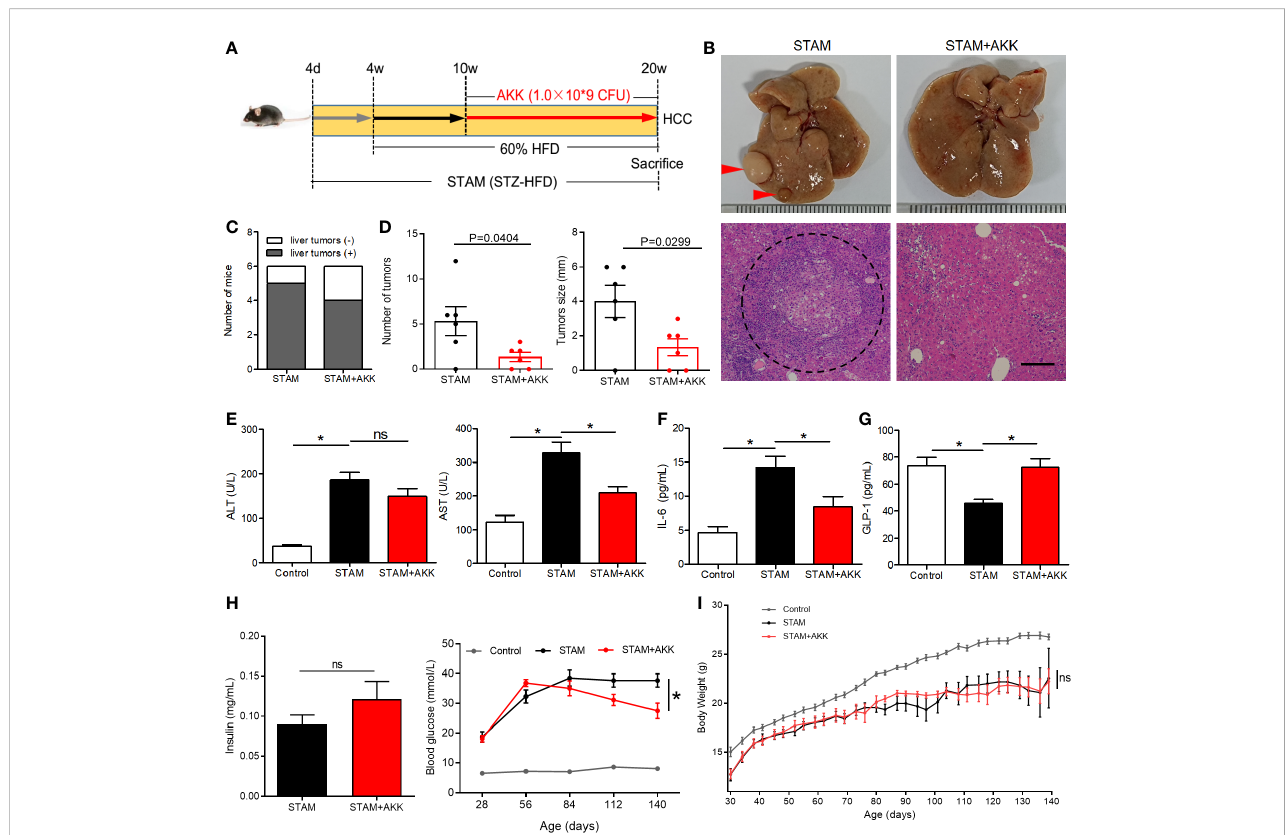
FIGURE 4 A muciniphila administration blunted hepatocarcinogenesis in STAM mice. (A) Experimental design and protocol. STAM mice were treated with A muciniphila or saline (Control) starting at 10 weeks of age for 10 weeks, and were killed at 20 weeks of age (n=6/group). (B) Macroscopic image of the liver surface (arrowheads: tumor) and histological images of liver tissues by H&E staining (dashed circle: tumor). Scale bars, 200 µm. (C) The total number of tumor nodules on the liver surface and the maximum diameter of the tumor nodules were compared between the groups. (D) The number of mice developed with liver tumor were counted. The serum levels of (E) ALT, AST, (F) GLP-1, (G) IL-6 and (H) insulin of the STAM mice (20 weeks of age) were measured. (H) The blood glucose were recorded every week. (I) The body weight was recorded every 4 days. Data represent mean ± SEM of two pooled experiments. *P<0.05 by unpaired Student ’ s t test. ns, not signi fi cant. STZ, streptozotocin; STAM, streptozotocin + high fat diet-treated mice; AKK, Akkermansia muciniphila ; AST, aspertate aminotransferase; ALT, alanine aminotransferase; GLP-1, glucagon-like